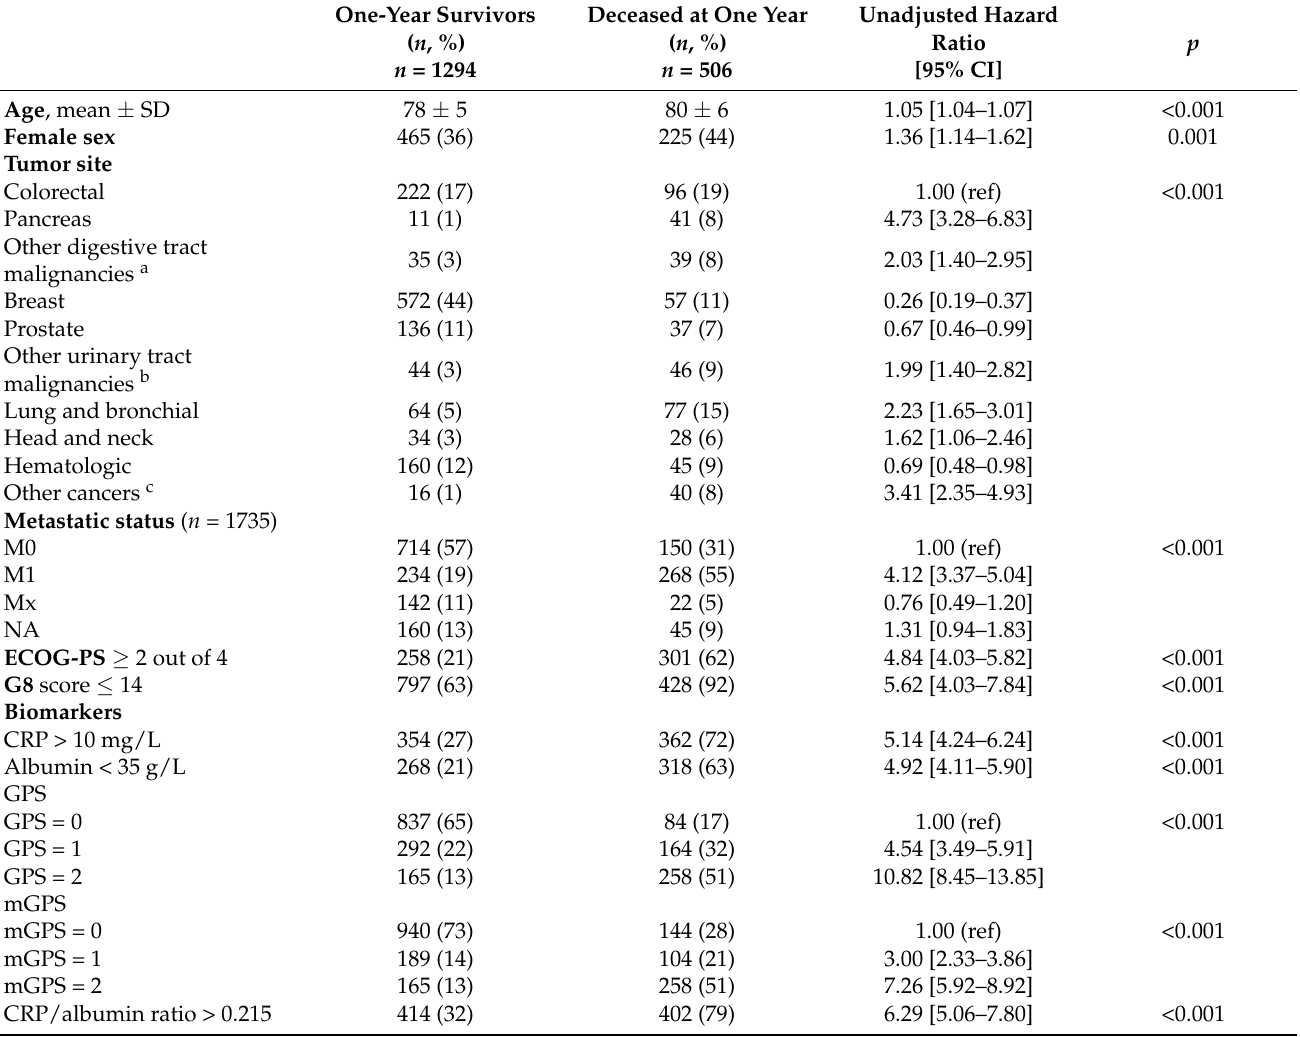
Table 2. Univariate analysis of clinical and laboratory variables associated with one-year mortality ( n =